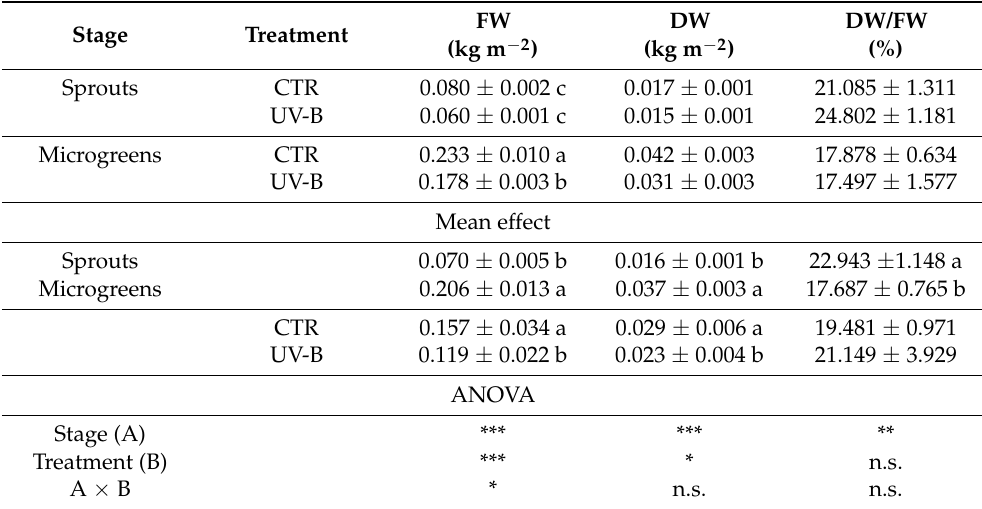
Table 2. Fresh (FW) and dry (DW) biomass and dry matter content (DW/FW) of flaxseed sprouts and microgreens grown indoors under controlled conditions under PAR (CTR) or PAR + UV-B radiation (UV-B). Data represent the mean ± SE ( n = 6). Means followed by the same letter are not statistically different for p = 0.05 after Tukey–Kramer test. Significance level: *** p ≤ 0.001; ** p ≤ 0.01; * p ≤ 0.05; n.s. = not